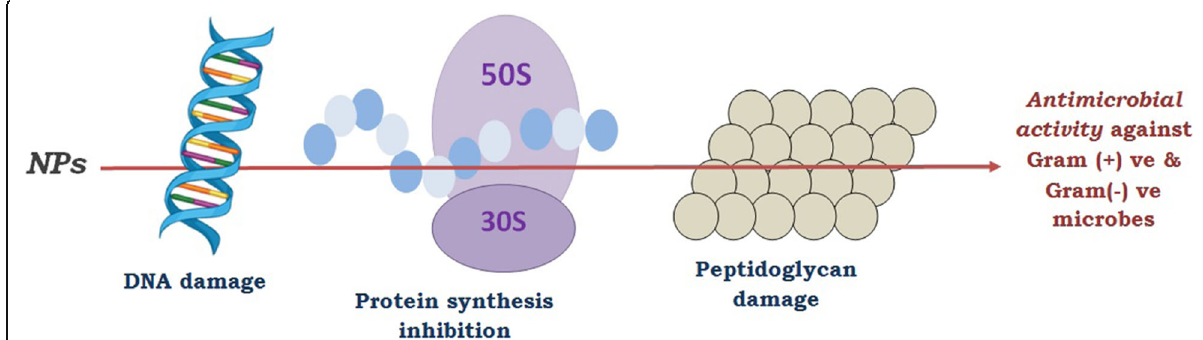
Fig. 5 Mechanism of antimicrobial action of